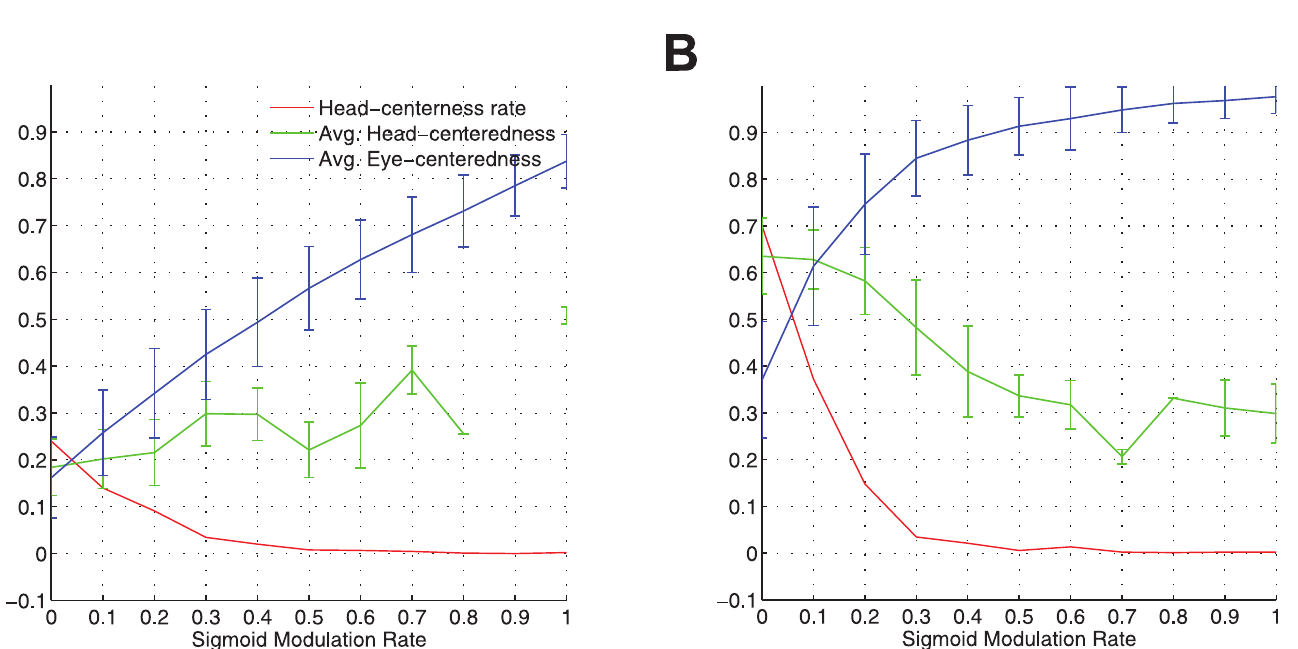
Fig 11. The effects of incorporating a mixed population of input neurons with both peaked and monotonic eye-position gain modulation. The plots show how the performance metrics vary with the monotonic modulation rate, p , which is the probability of each input neuron having a monotonic eye-position gain modulation. Results are presented showing the response characteristics of the output neurons before training (A) and after training (B) . Conventions are similar to Fig 10. It is evident that the head-centredness rate decreased as the sigmoid modulation rate increased, both in the trained and untrained models. However, as long as the sigmoid modulation rate is less than 30%, the trained model had a higher proportion of head-centred output neurons than the untrained model.